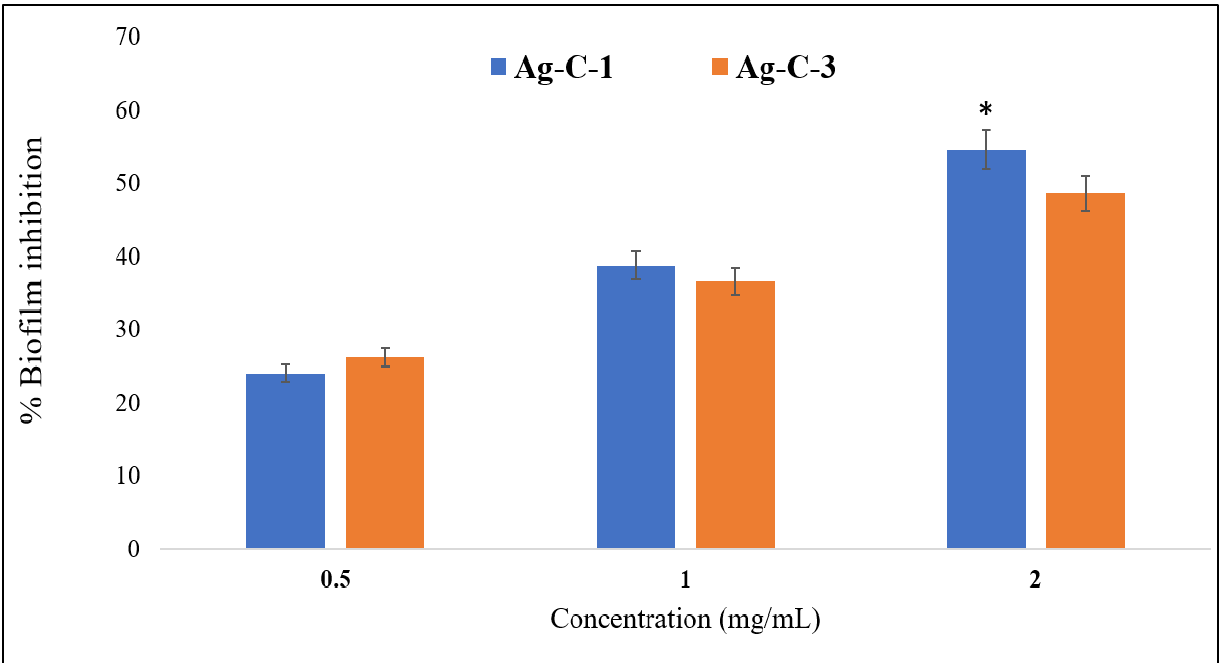
Figure 8. Effects of Ag-C-1 and Ag-C-3 on the biofilm-forming abilities of C. albicans . * p < 0.05.